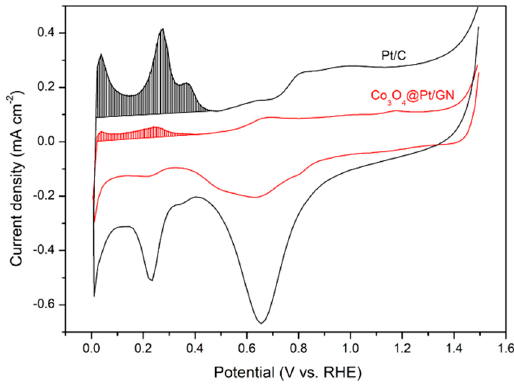
Figure 8. The rotating disc electrode (RDE) measurements for Co 3 O 4 @Pt / GN. ( a ) Oxygen reduction reaction (ORR) activity at various rotation speeds and ( b ) the Koutecky-Levich plot at different potentials.